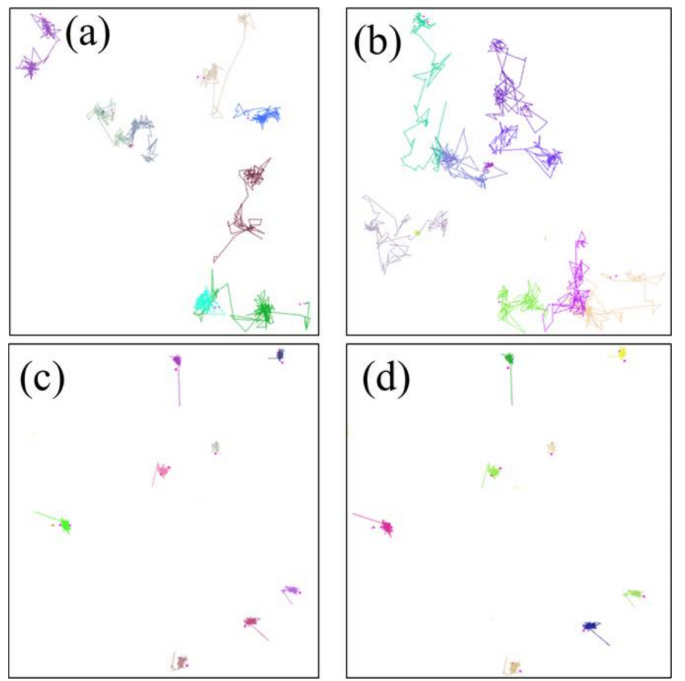
Figure 8. The motion trajectories of the oxygen molecules in the NBR: ( a ) 298.15 K/under the free state; ( b ) 383.15 K/under the free state; ( c ) 298.15 K/under the compression state; ( d ) 383.15 K/under the compression state. (Each color plot represents a motion trajectory of oxygen molecule).